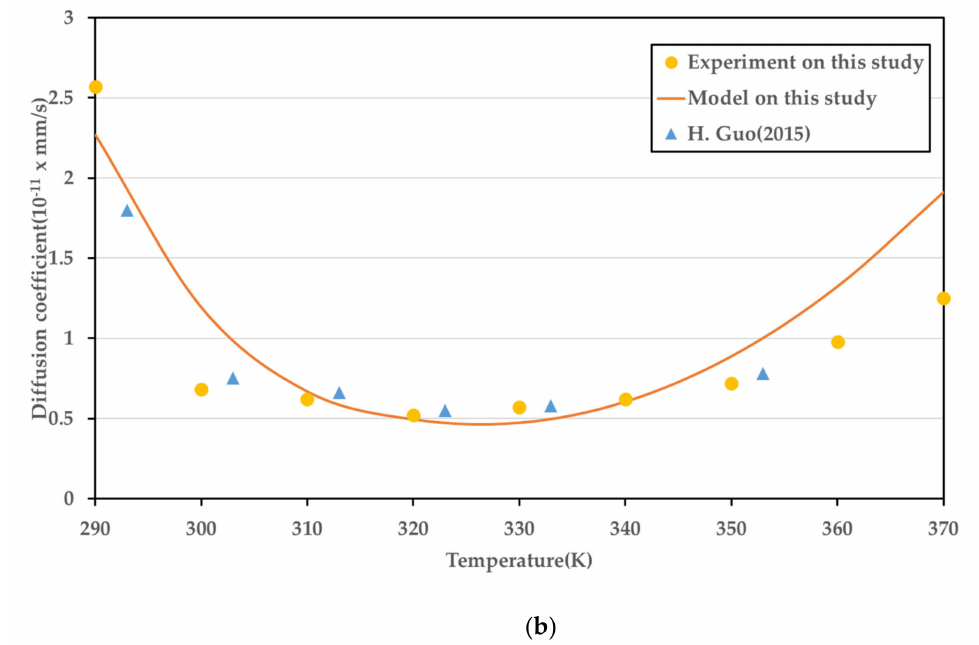
Figure 11. ( a ) Comparison of CO 2 sorption in PMMA in this study and the studies of Koros et al. [32] and Liu et al. [33]. ( b ) Comparison of diffusion coefficient of the PMMA–CO 2 mixture in this study and that in the study of Guo et al.